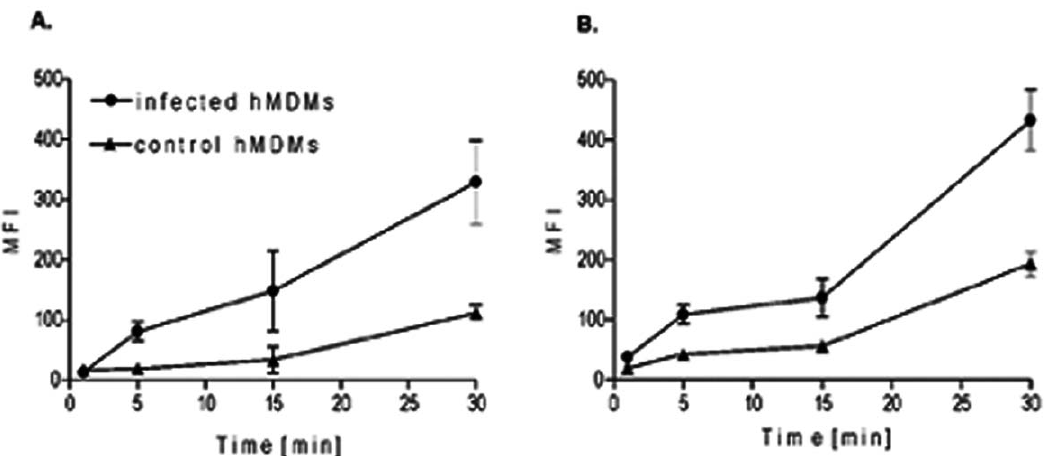
Figure 2.S.aureusinfected macrophages retained their bactericidal functions. Control hMDMs, and cells 4 days post infection with S. aureus strain Newman, were stimulated to phagocytose either live bacteria at a MOI of 1:25 (1.25 6 10 7 CFU) (panel A) or latex beads (panel B). Generation of reactive oxygen species (ROS) determined as the level of the mean fluorescence intensity (MFI) was measured at various time intervals. The data shown is representative of at least three separate experiments, performed in triplicate, using hMDMs derived from different donors.